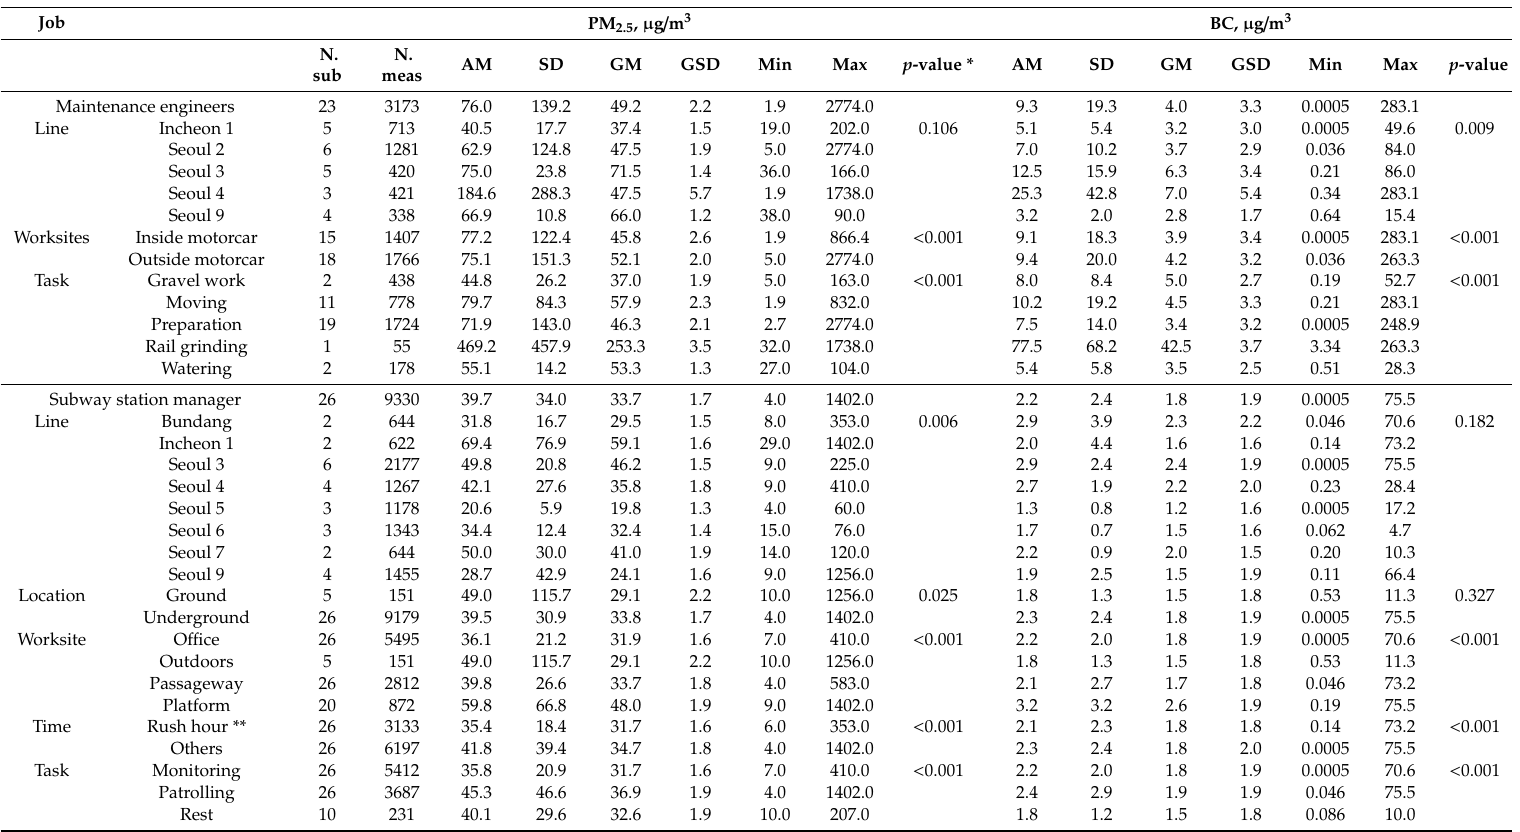
Table 2. Summary of exposure levels to PM 2.5 and black carbon according to job and